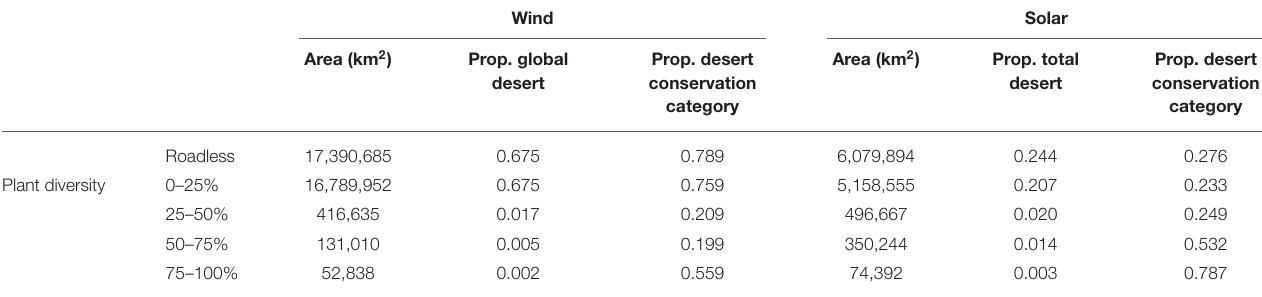
TABLE 2 | Total area, proportion of total global desert area, and proportion of total desert conservation category area that contain economically viable wind and solar resources for each desert conservation